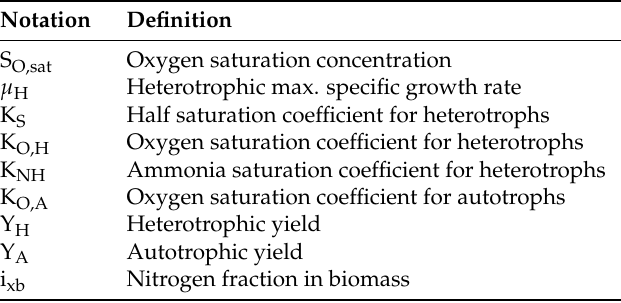
Table 3. Kinetic parameters and stoichiometric coefficient characteristics.